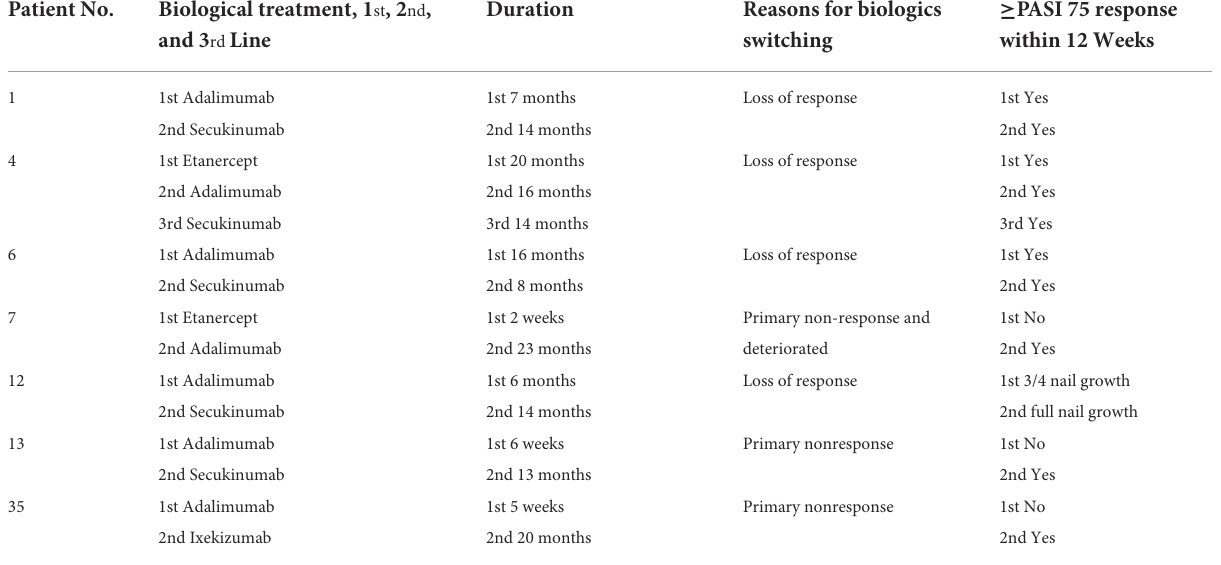
TABLE 3 Biologics switching: detailed patient data. Patient